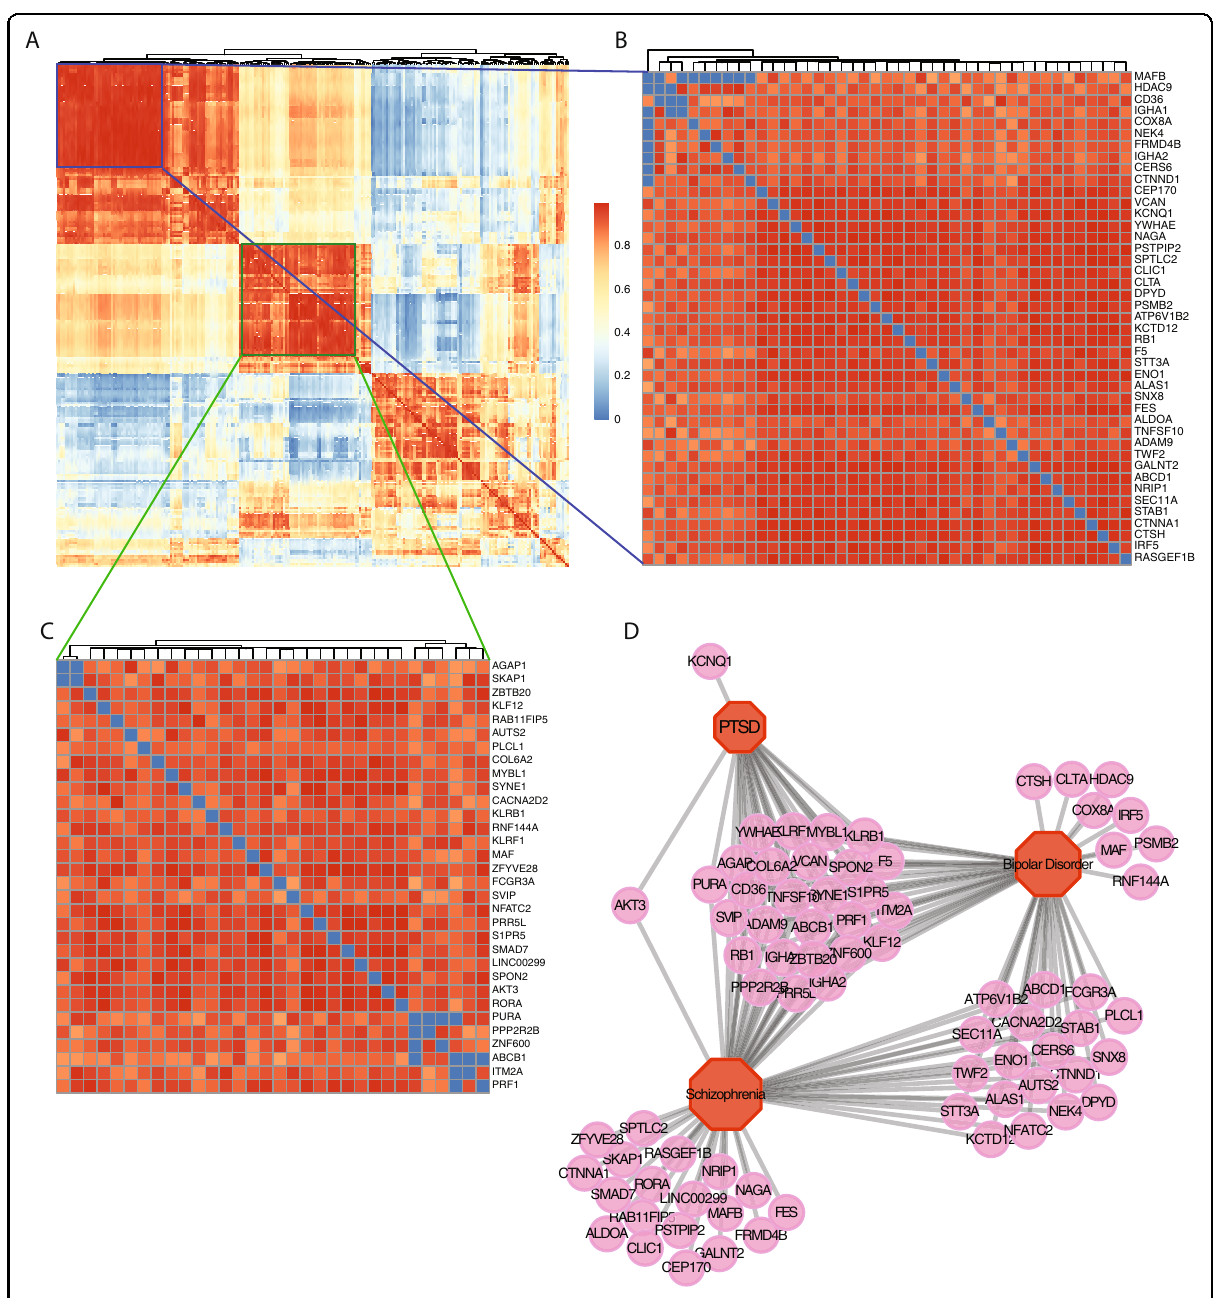
Fig. 5 Coexpression and clustering analyses. A Coexpression and clustering analyses of the signi fi cant shared genes of SARS-CoV-2 with the bipolar disorder, PTSD and schizophrenia, reveal that SARS-CoV-2 infection could perturb some genes that are also affected in bipolar disorder, PTSD, and schizophrenia. Two clusters were selected based on the co-expression values in all the transcriptome samples used in this study. B One cluster is explored based on the correlation values>0.8 and it contains 43 genes that are coexpressed together. C The second cluster is also explored based on the correlation values>0.8 and it contains 32 genes that are coexpressed together. D The network of the genes of these two co- expressed clusters that shows some genes in fl uenced by the SARS-CoV-2 are concordant in bipolar, PTSD, and